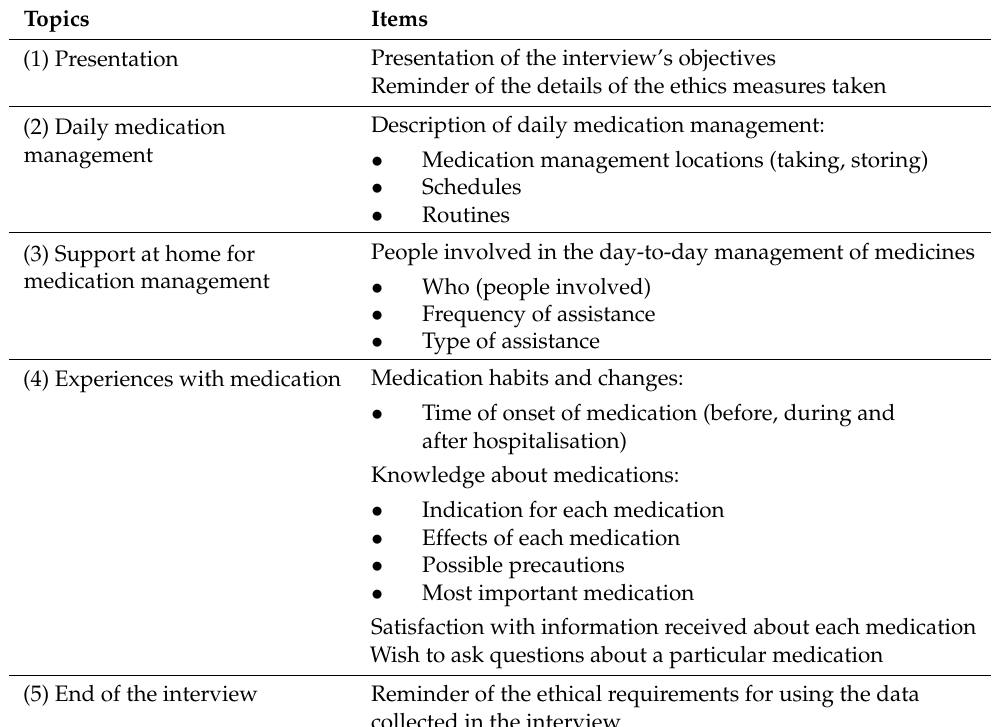
Table A2. Interview guide 2 with the older adult.